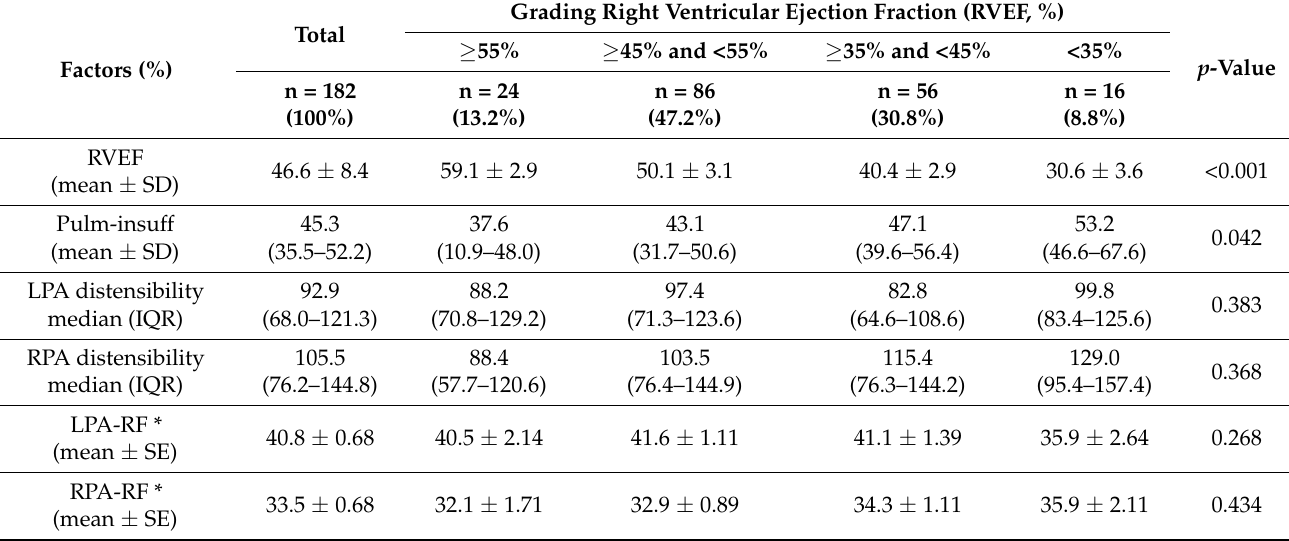
Table 5. Factors associated with right ventricular